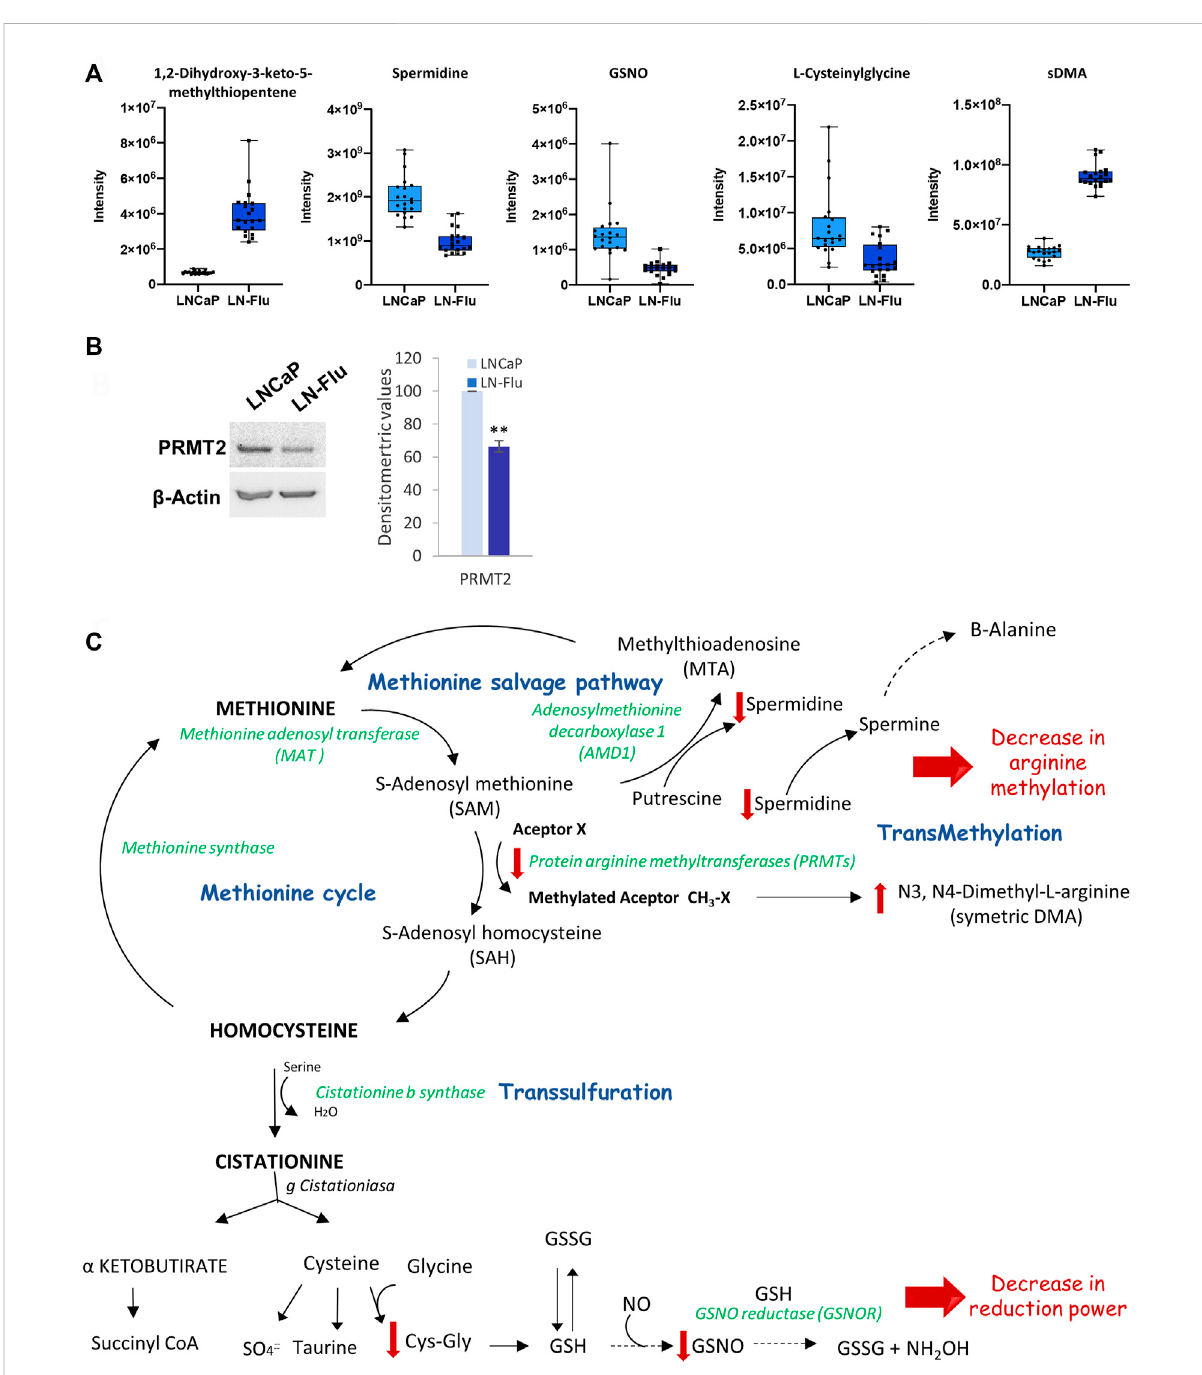
FIGURE 7 Methionine metabolism and methylation in prostate LN-Flu cells. (A) Box and whisker plot of metabolites involved in the pathway. (B) Levels of Proteinargininemethyltransferase2(PRMT2) determinedbyWesternblot.Densitometricanalysisofthewesternblotbandsfromthreeindependent experiments is shown on the right. Results are the mean ± S.D. of three independent experiments. ** p < 0.01 signi fi cant difference between LNCaP and LN-Flu cells by two-way ANOVA and Sidak ’ s multiple comparisons test. (C) Methionine metabolism (Methionine cycle, methionine salvage pathway and transsulfuration) showing the metabolites and enzymes we have found up (red arrow up) or down (red arrow down) in LN-Flu cells compared to LNCaP